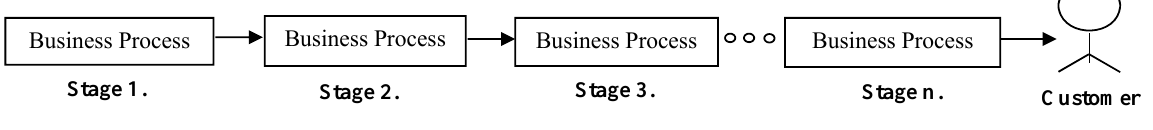
Fig. 2. Serial Supply Chain (Garg et al.,